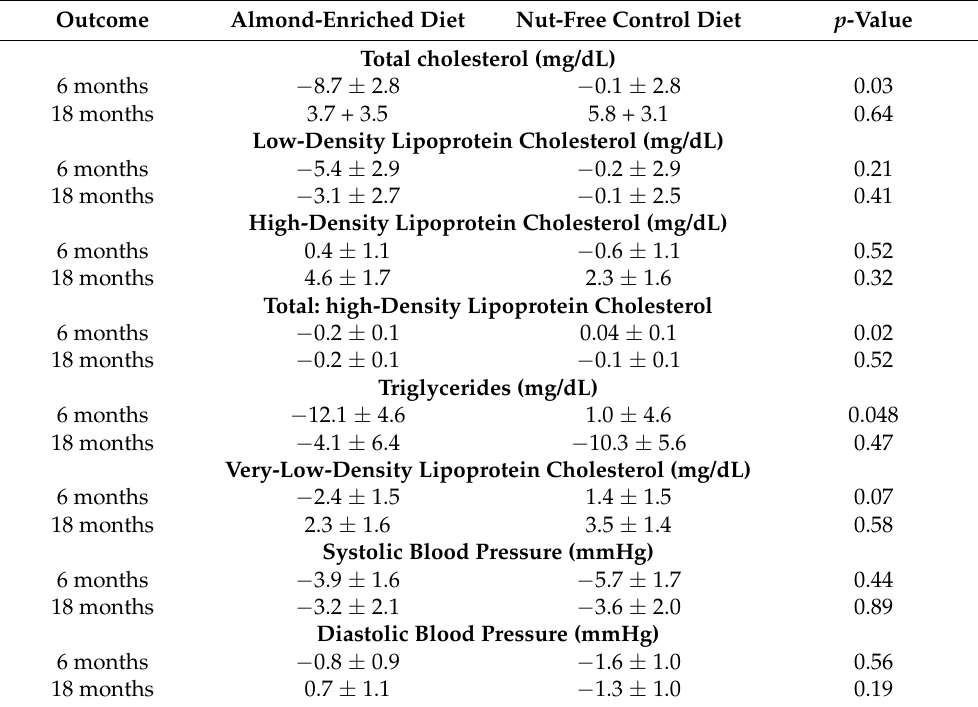
Table 7. Effect of 500 kcal deficit/day almond vs. control LCDs on cardiometabolic health biomarkers